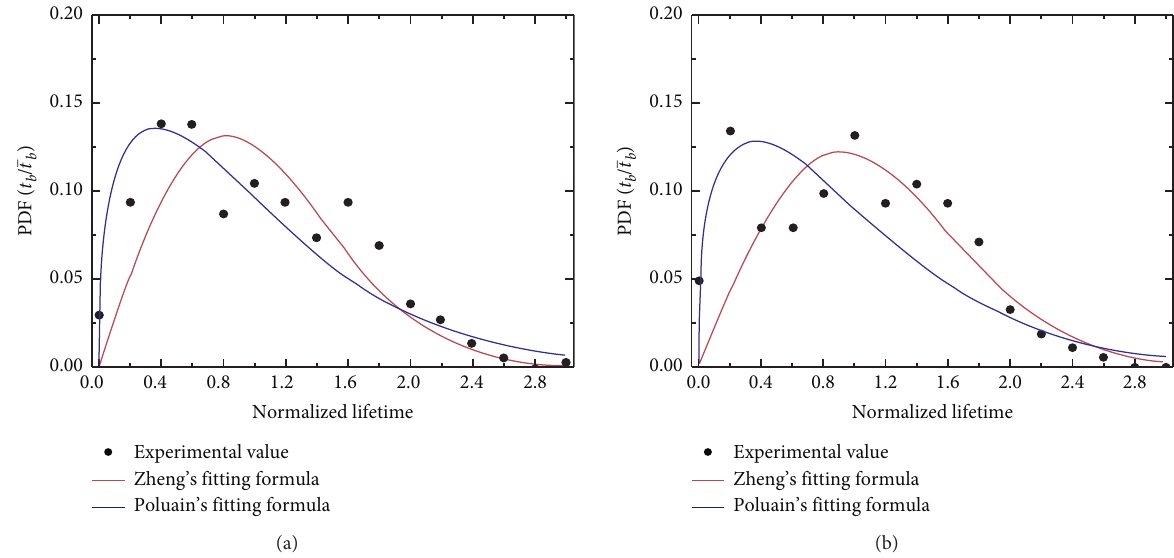
Figure 9: Normalized bubble lifetime distribution and fitting curves: (a) cap diameter � 11-12mm and (b) cap diameter �